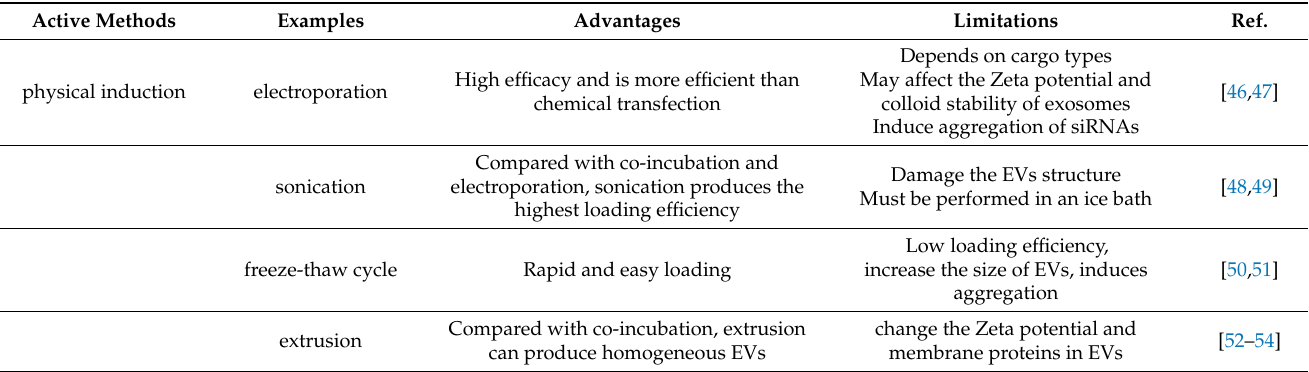
Table 1. Advantages and limitations of exosomes loading